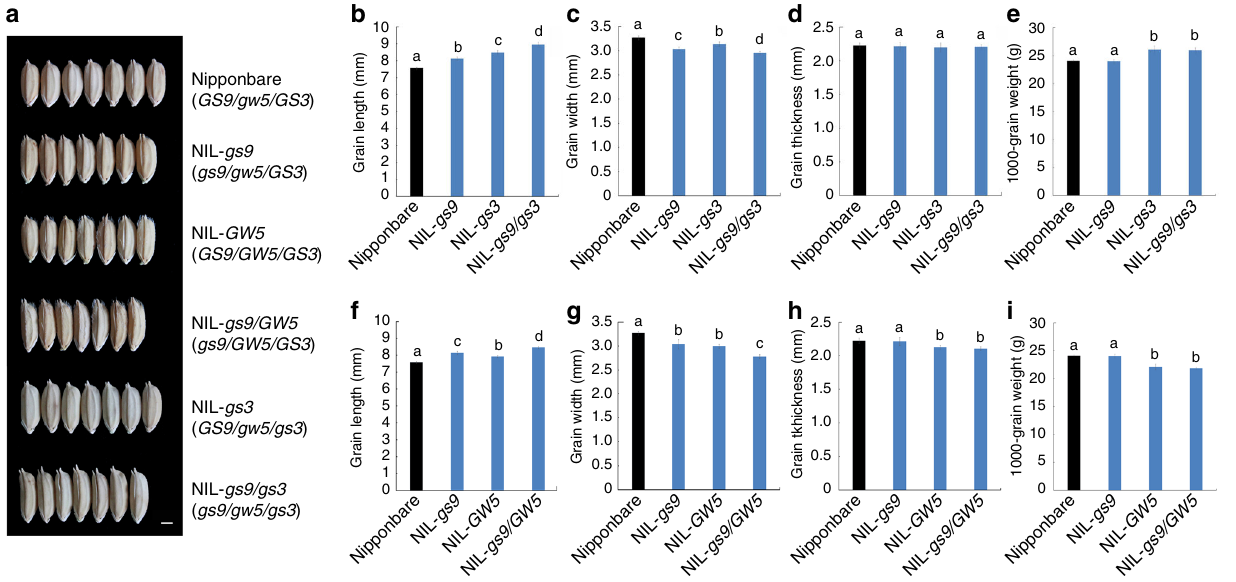
Fig. 6 Genetic interaction between GS9 and other grain size genes, GS3 and GW5 . a Comparison of grain shape among Nipponbare and its various near- isogenic lines (NILs) carrying different combinations of the alleles of GS9 , GW3 , and GW5 . Nipponbare ( GS9 / gw5 / GS3 ) means the wild-type Nipponbare carrying the combination of alleles of GS9GS9 / gw5gw5 / GS3GS3 , and the NILs harbored corresponding alleles as shown in Nipponbare background. NIL- GW5 , near-isogenic line with the GW5 allele in Nipponbare; NIL- gs3 , near-isogenic line with the gs3 allele in Nipponbare; NIL- gs9 / GW5 , pyramiding line from NIL- gs9 and NIL- GW5 ; NIL- gs9 / gs3 , pyramiding line from NIL- gs9 and NIL- gs3 . Scale bar, 2 mm. b – i Grain length ( b and f ), width ( c and g ), thickness ( g and h ), and 1000-grain weight ( e and i ) of Nipponbare and NILs. Data are given as means ± SD ( n = 30 in b – d , f , g , n = 3 in e , i